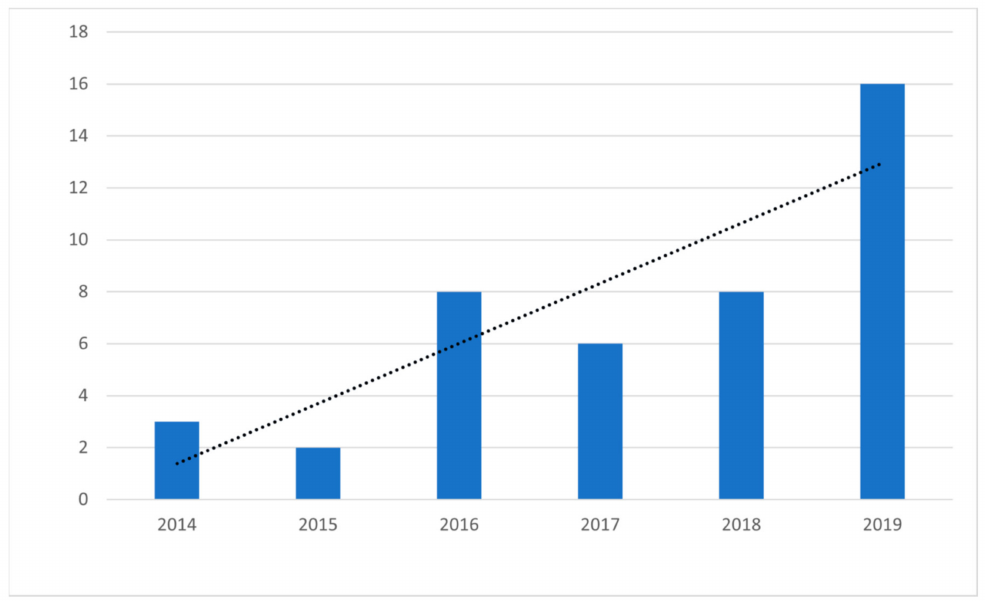
Figure 2. Year in which studies were